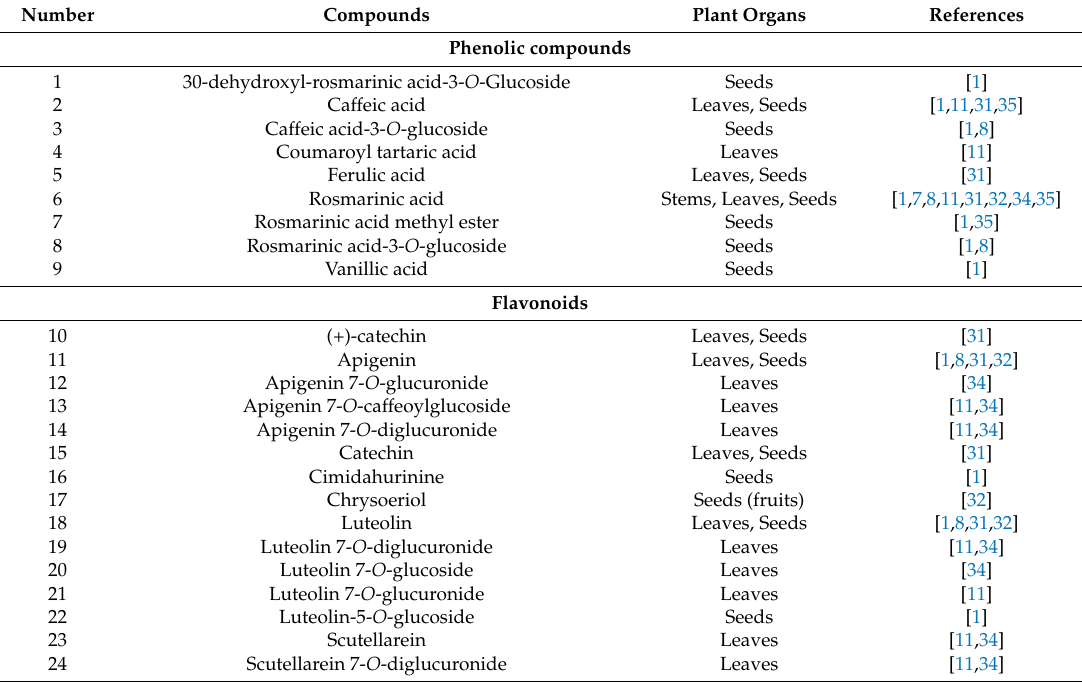
Table 1. Phenolic acids, flavonoids, and anthocyanin compounds found in Perilla frutescens species. Number